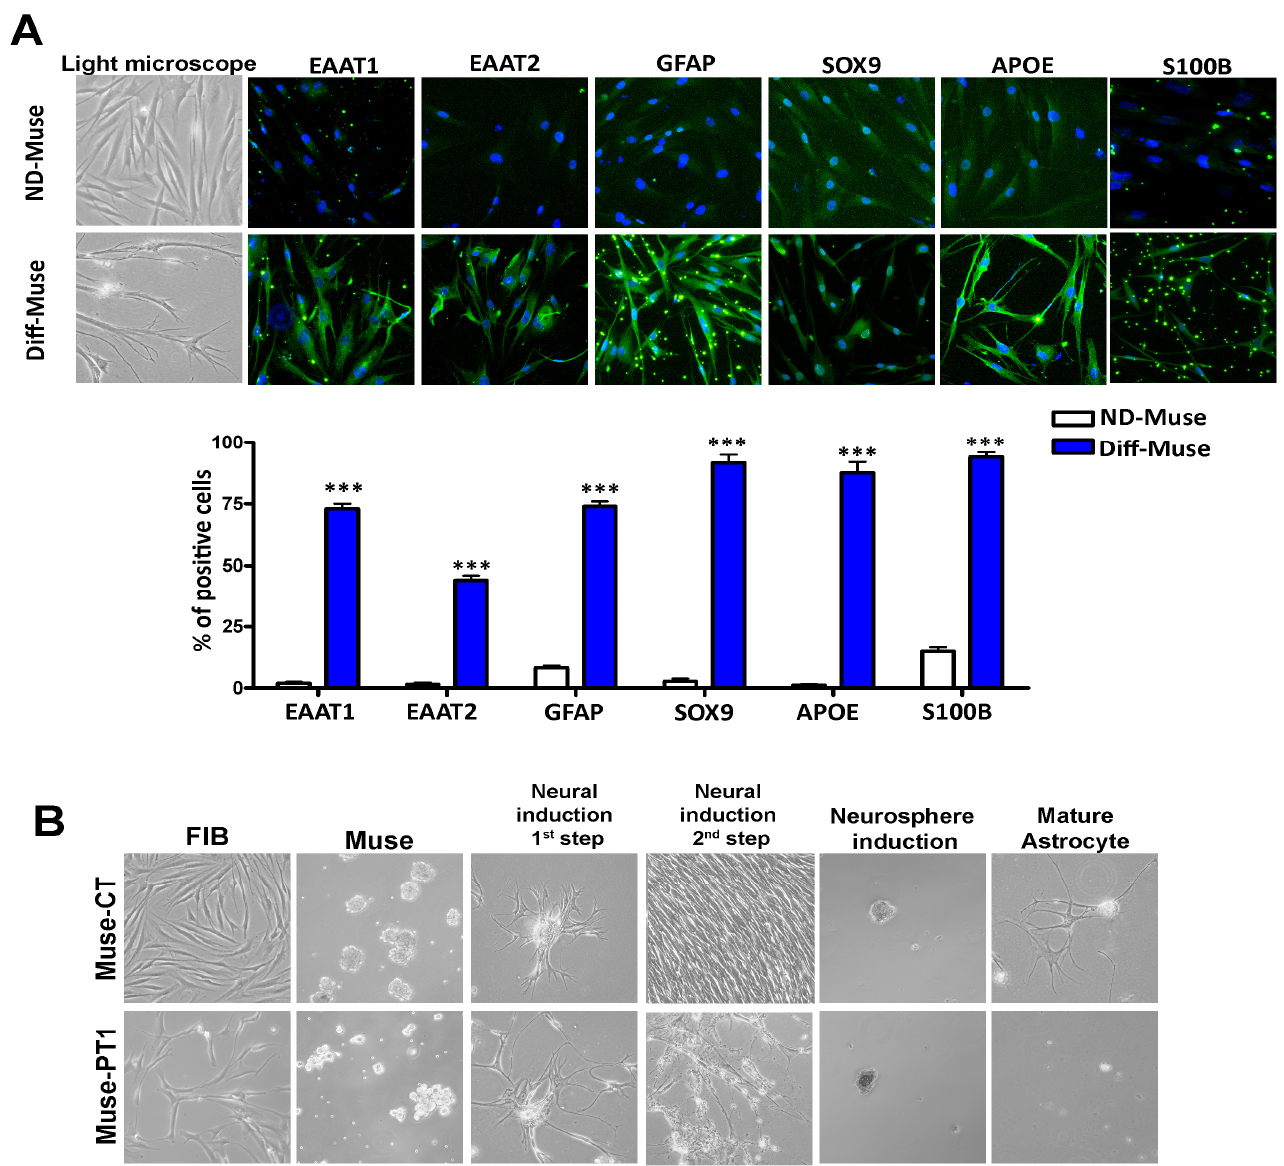
Figure 4. Astrocyte differentiation of Muse stem cells . Panel ( A ): Examples of immunostaining on Muse stem cells following astrocyte differentiation (200× magnification). The staining for several Muse; Diff-Muse). Some green background dots are due to Matrigel present on the samples.